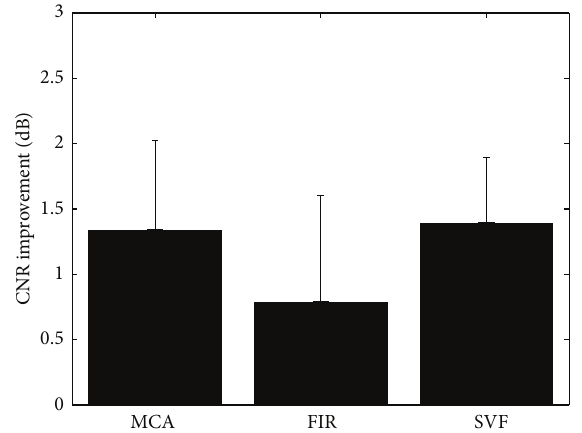
Figure13:MeanimprovementCNRcomparisonforMCA,SVF,and FIR clutter reduction methods over the unfiltered echo data. Error bars represent standard deviation over eight